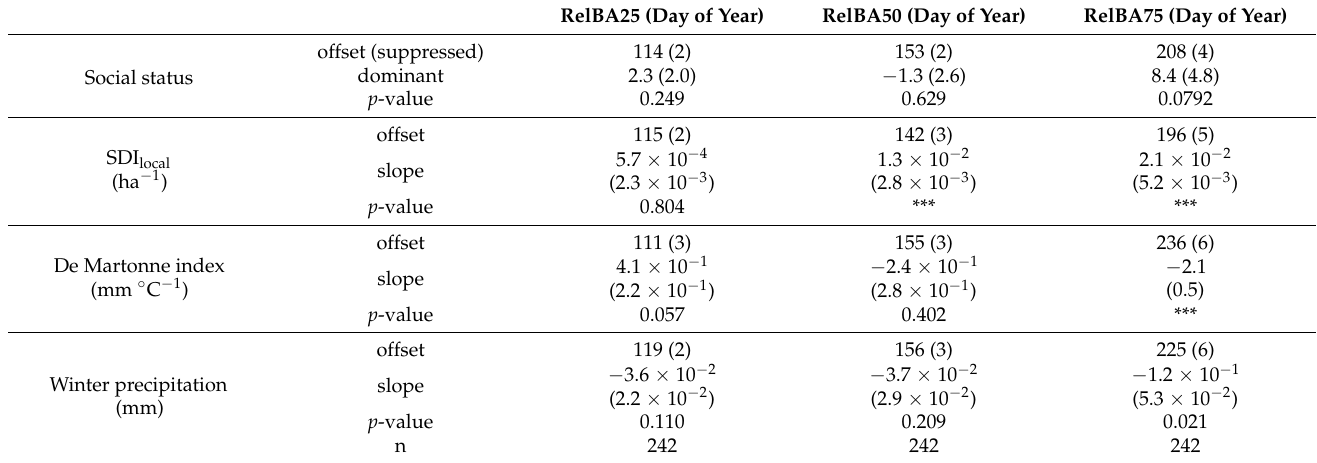
Table 3. The results of 12 linear regression analyses between the three dependent (RelBA25, RelBA50, RelBA75) and the four independent variables (social status, SDI local , De Martonne index, winter precipitation). Numbers in brackets next to the regression coefficients represent the standard error.